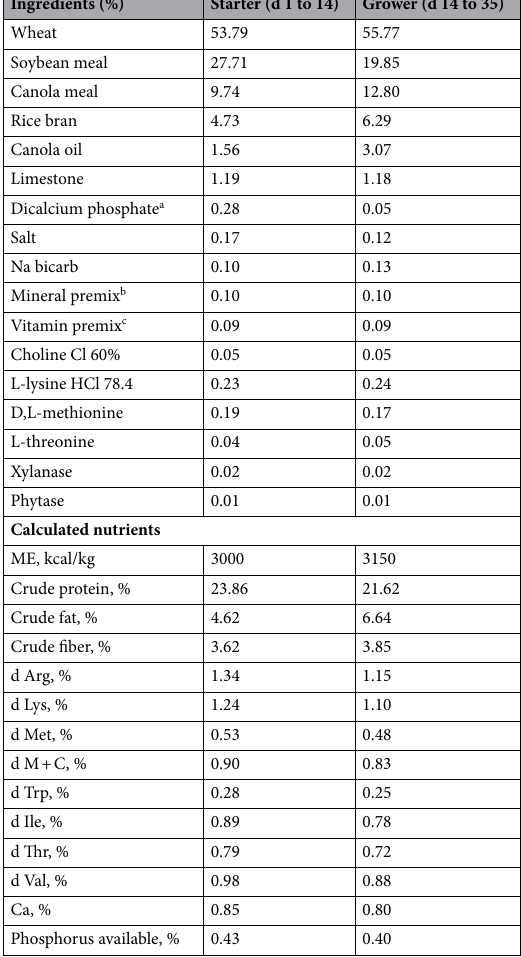
Table 1. Diet composition and nutritive value of the experimental diets (as-fed basis). a Dicalcium phosphate contained: phosphorus, 18%; calcium, 21%. b The Cu-free trace mineral concentrate supplied per kilogram of diet: Zn (sulphate), 60 mg; Fe (sulfate), 40 mg; I (iodide), 1.5 mg; Se (selenate), 0.3 mg; Mn (sulfate), 80 mg; millrun-based carrier, 128 mg; mineral oil, 100 mg. c Vitamin concentrate supplied per kilogram of diet: